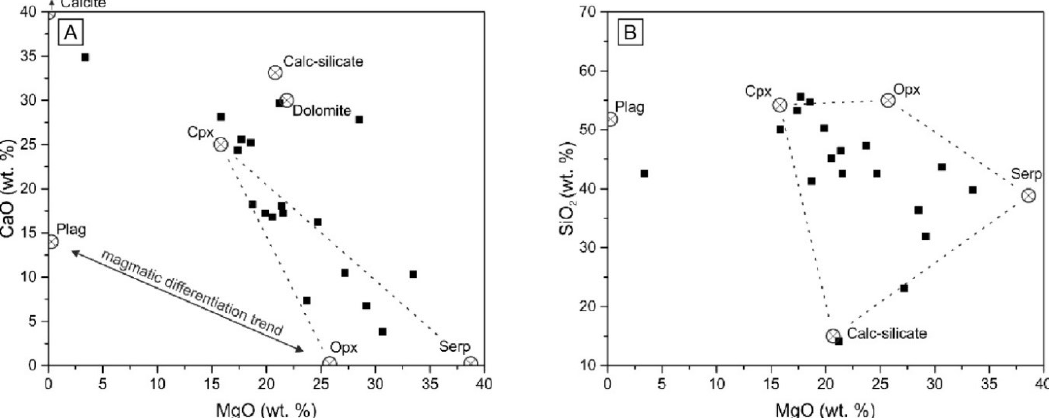
Figure 6. Binary variation diagrams of ( A ) CaO vs. MgO; ( B ) SiO 2 vs. MgO (black squares represent